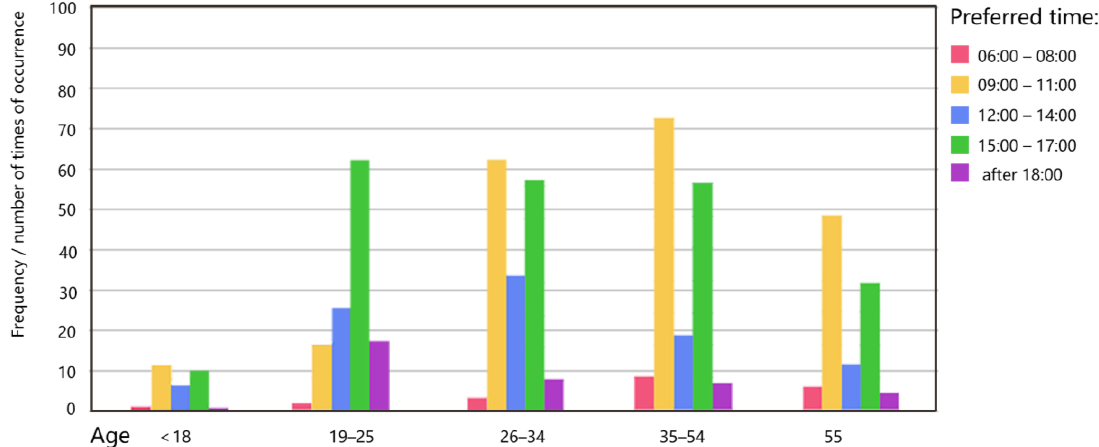
Figure 13. Frequency distribution of interviewees of different ages and their preferred time.